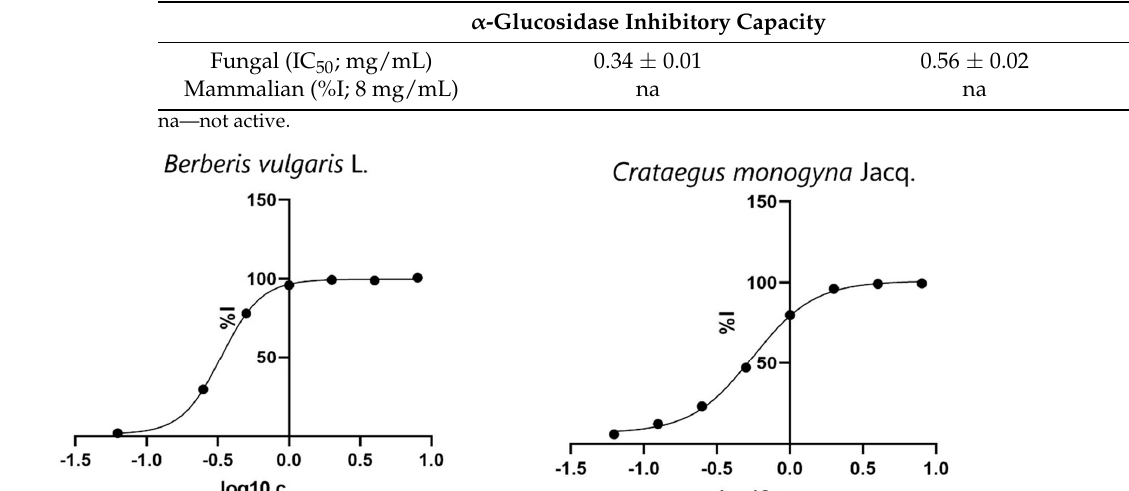
Table 3. Inhibitory activity against fungal and mammalian α -glucosidase of optimized extracts.